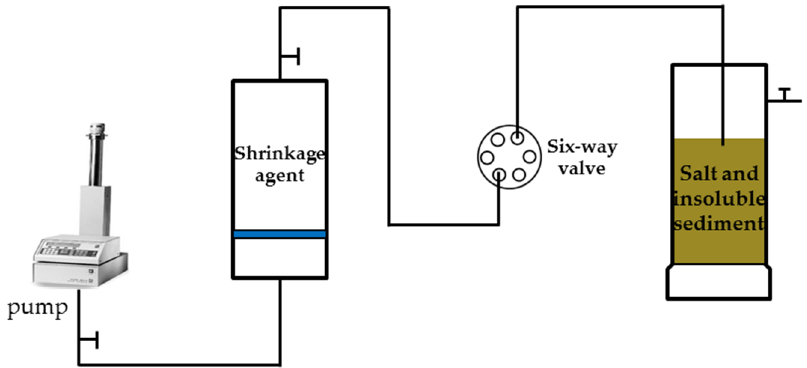
Figure 1. Schematic diagram of dynamic shrinkage experiment device. Firstly, the insoluble sediments from the gas storage were ground into powder of corresponding meshes, washed with a dichloromethane solution to remove oil and salt for 24 h, and dried in an oven at 105 ◦ C for 24 h until a constant weight was